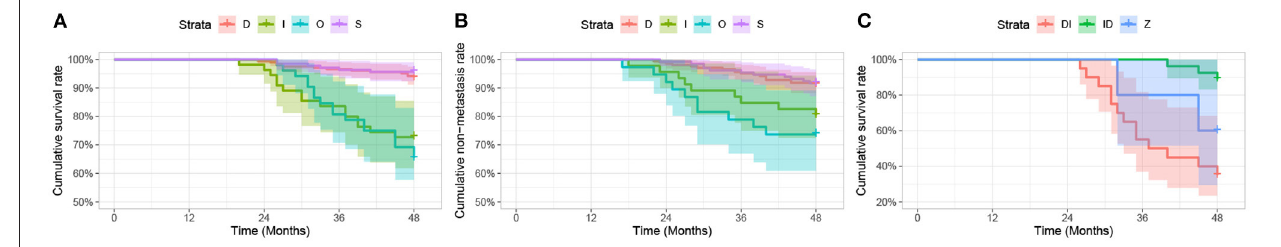
FIGURE 8 | Kaplan-Meier analysis. (A,B) Kaplan-Meier analysis of survival curve (A) and non-metastasis curve (B) for patients with uveal melanoma after iodine 125 plaque brachytherapy by tumor regression patterns (D vs. S vs. I vs. O), expressed in three follow-up visits. (C) Kaplan-Meier analysis of survival curve for patients with uveal melanoma after iodine 125 plaque radiotherapy by tumor regression patterns (DI vs. ID vs. Z), expressed in three follow-up